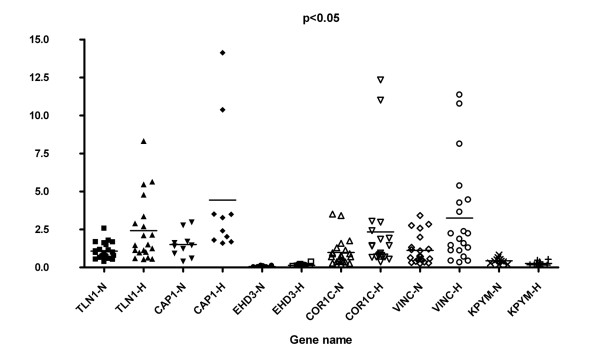
The mRNA expression of six genes selected from 13 differentially expressed proteins (p < 0.05). TLN1-H and TLN1-N represent TLN1 from HIV-positive patients and healthy controls respectively.